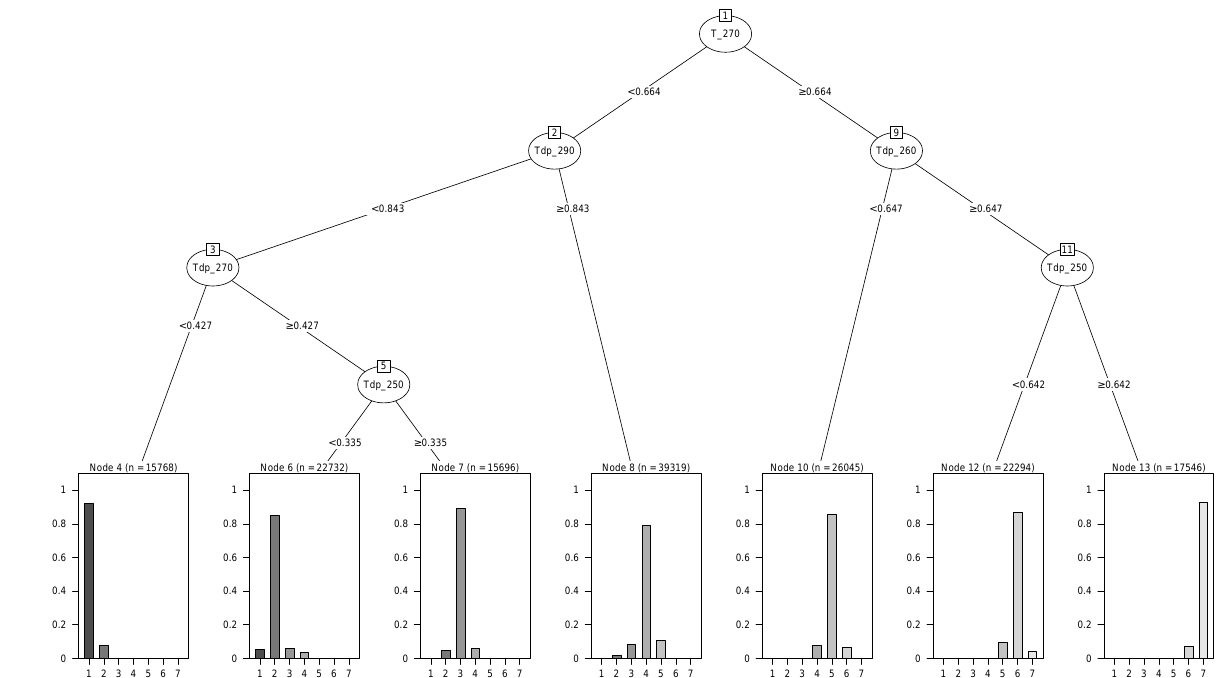
Figure 13. Decision tree obtained from the seven-cluster partition built with the training database and EM-VII.